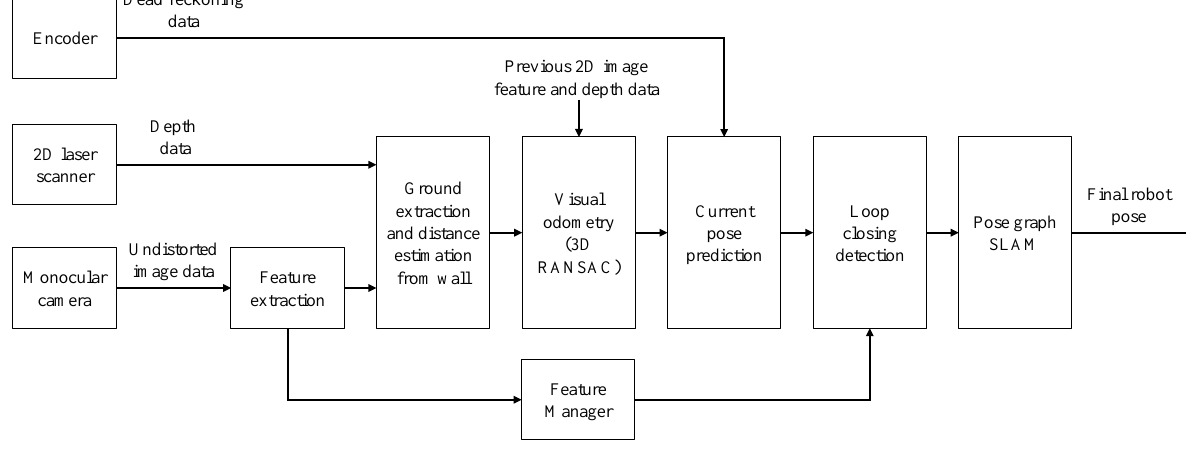
Figure 6. Flow diagram of the overall algorithm. For the final robot pose, predictions using the sensor fusion method are exploited. The robot pose is predicted using dead-reckoning of the encoder and is updated using feature matching through loop closure